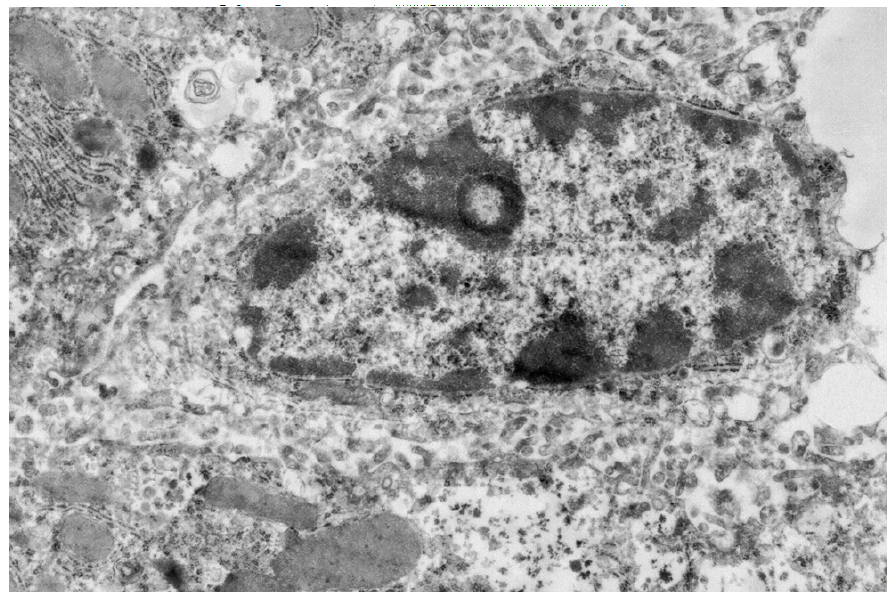
Figure 2. Liver macrophage fragment, 24 h after mannan A (50 mg/kg) administration. Magnification 6000×.